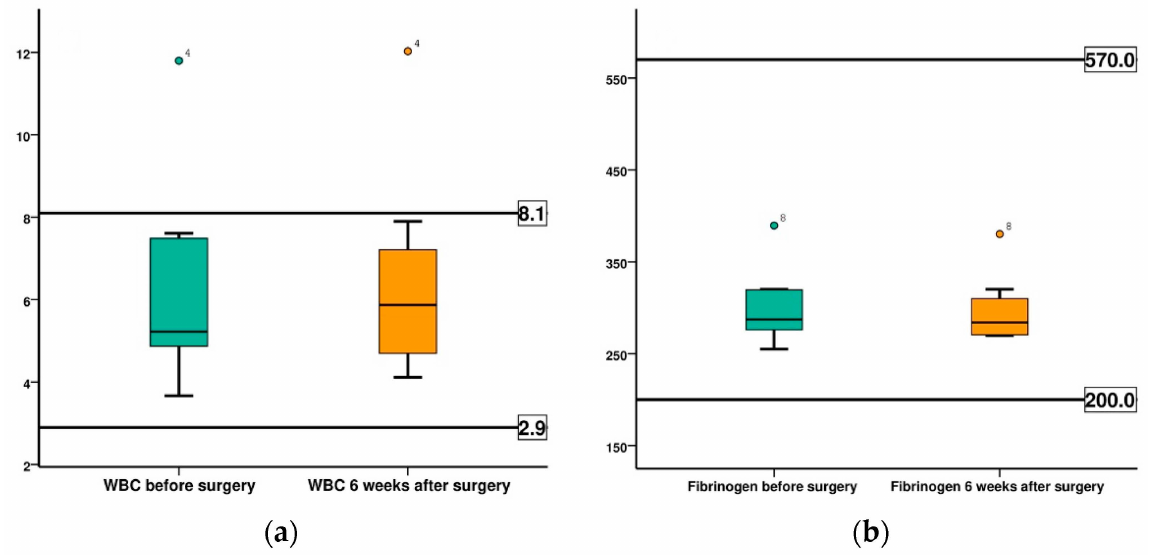
Figure 20. Comparison of the evolution of leukocytes and fibrinogen, in both groups, before surgery (BS) and at 6 weeks after surgery (AS): ( a ) leukocytes; ( b )